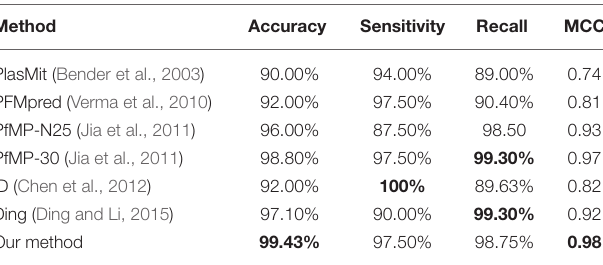
TABLE 4 | Cross-validation performance of PM-OTC compared with other methods on